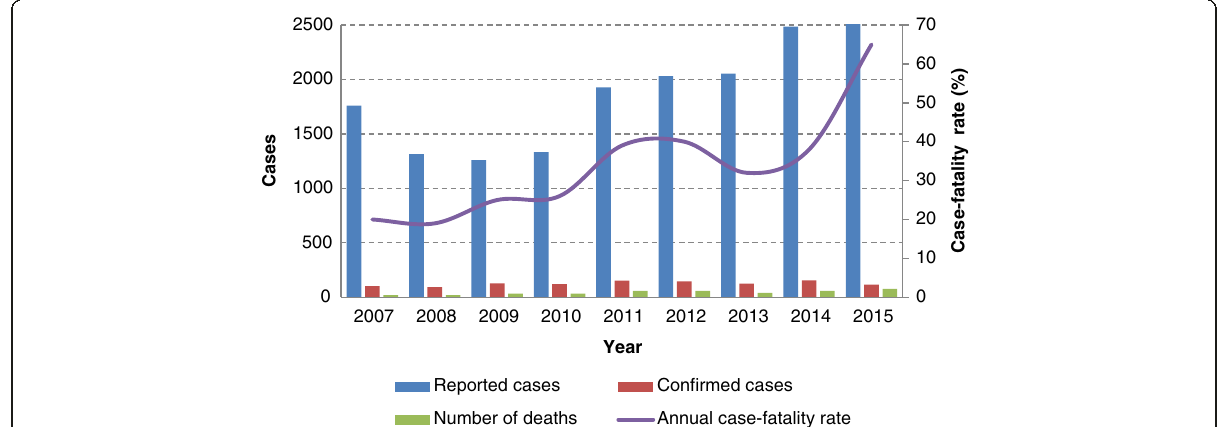
Fig. 1 Absolute number of reported cases, confirmed ones and deaths due to spotted fever and annual case-fatality rate between 2007 and 2015 in